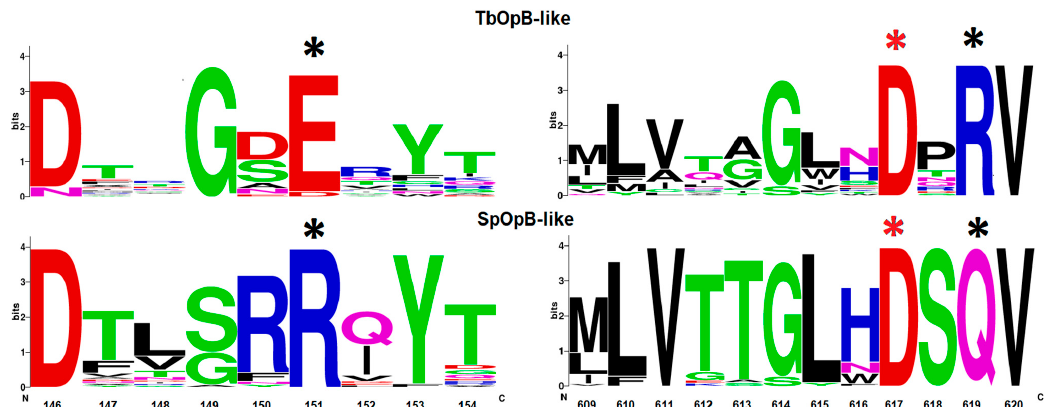
Figure 3. Logo-plot of amino acid patterns surrounding the initial combinations of E/D-R and R-Q in the TbOpB- and SpOpB-like groups, respectively. The height of the letters is proportional to the frequency of occurrence of the corresponding residue. Residues that promote or prevent the formation of a salt bridge are marked with black asterisks, catalytic D, with red asterisks. The numbering corresponds to the SpOpB sequence.